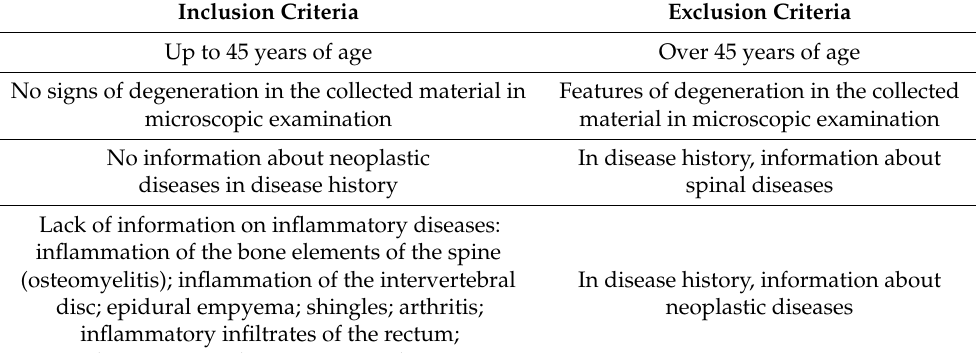
Table 2. Inclusion and exclusion criteria for the control